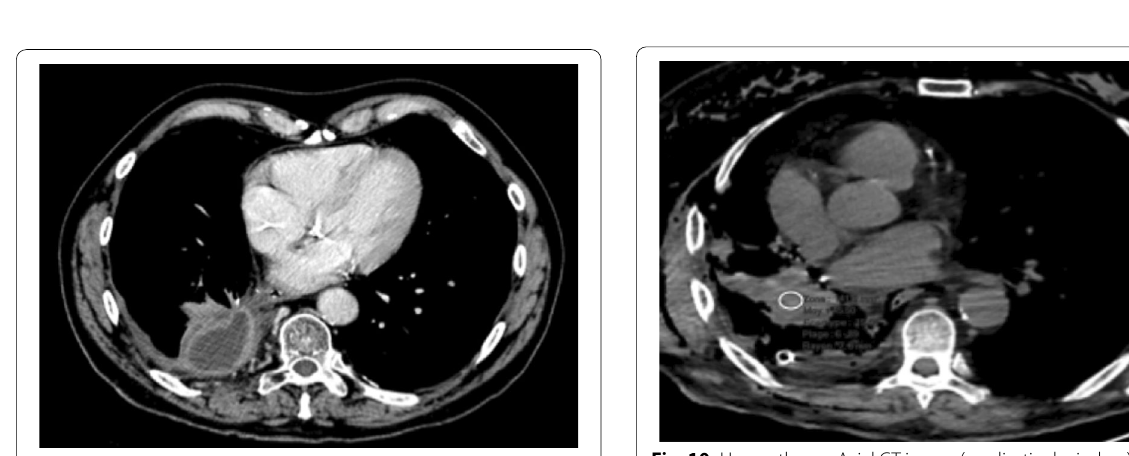
Fig. 10 Haemothorax. Axial CT image (mediastinal window) showing haemothorax after right pneumonectomy. A region of interest placed in the effusion indicates a spontaneous density around 50